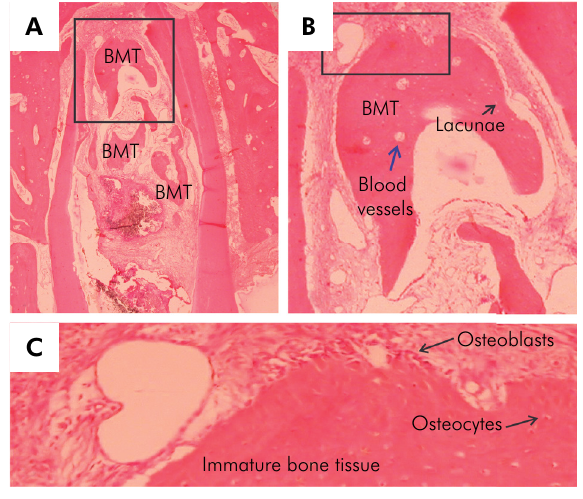
Figure 3. (A) Photomicrograph of a specimen from the propolis paste group showing bone-like mineralized tissue (BMT) formation in the root canal space (20× magnification). (B) Detail of the area shown in A, evidencing the presence of lacunae hosting osteocytes (black arrow) and blood vessels (blue arrow). (C) Detail of the area shown in B, evidencing presence of osteocyte-like cells embedded in the matrix and osteoblast-like cells embedded in the tissue surface.